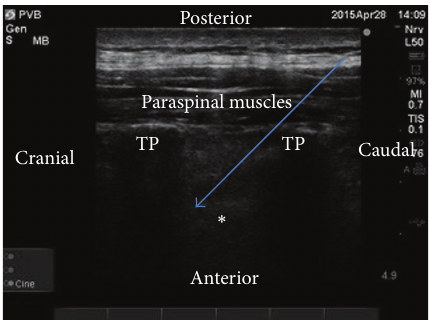
Figure 1: Using a linear transducer (10–5MHz, Sonosite Bothel, WA), a paramedian oblique sagittal scan was used to obtain the view of the transverse processes. A slight lateral tilt was applied to optimize visualization of the pleural lining (white asterisk). The needle was advanced in a caudal to cranial direction until the tip was placed underneath the costotransverse ligament. After negative aspiration, hydrodissection with saline was used and anterior displacement of the pleura was confirmed. TP = transverse process. Bluearrowdelineatesneedletrajectory.Thewhiteasteriskrepresents the